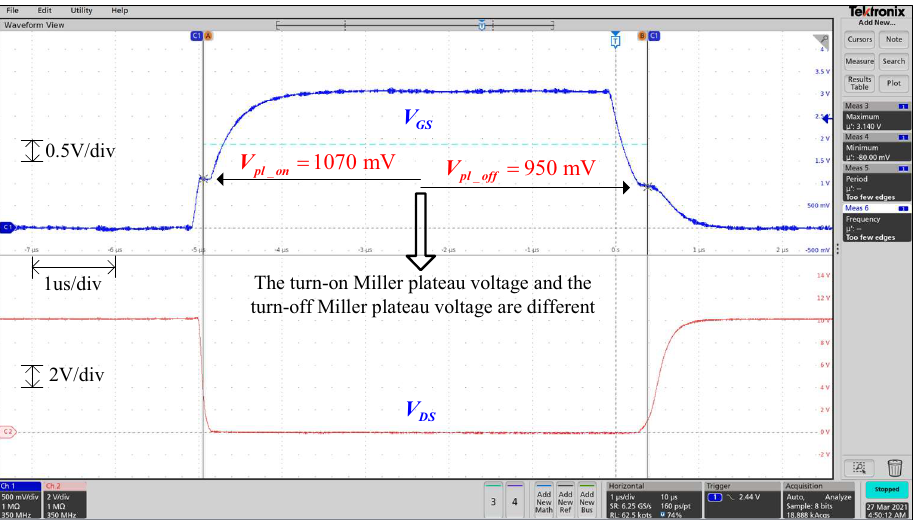
Figure 4. Measured switching waveforms of V GS and V DS for NCE2030K when V dr = 3 V, I L = 0.1 A, and C DS _ ext = 1